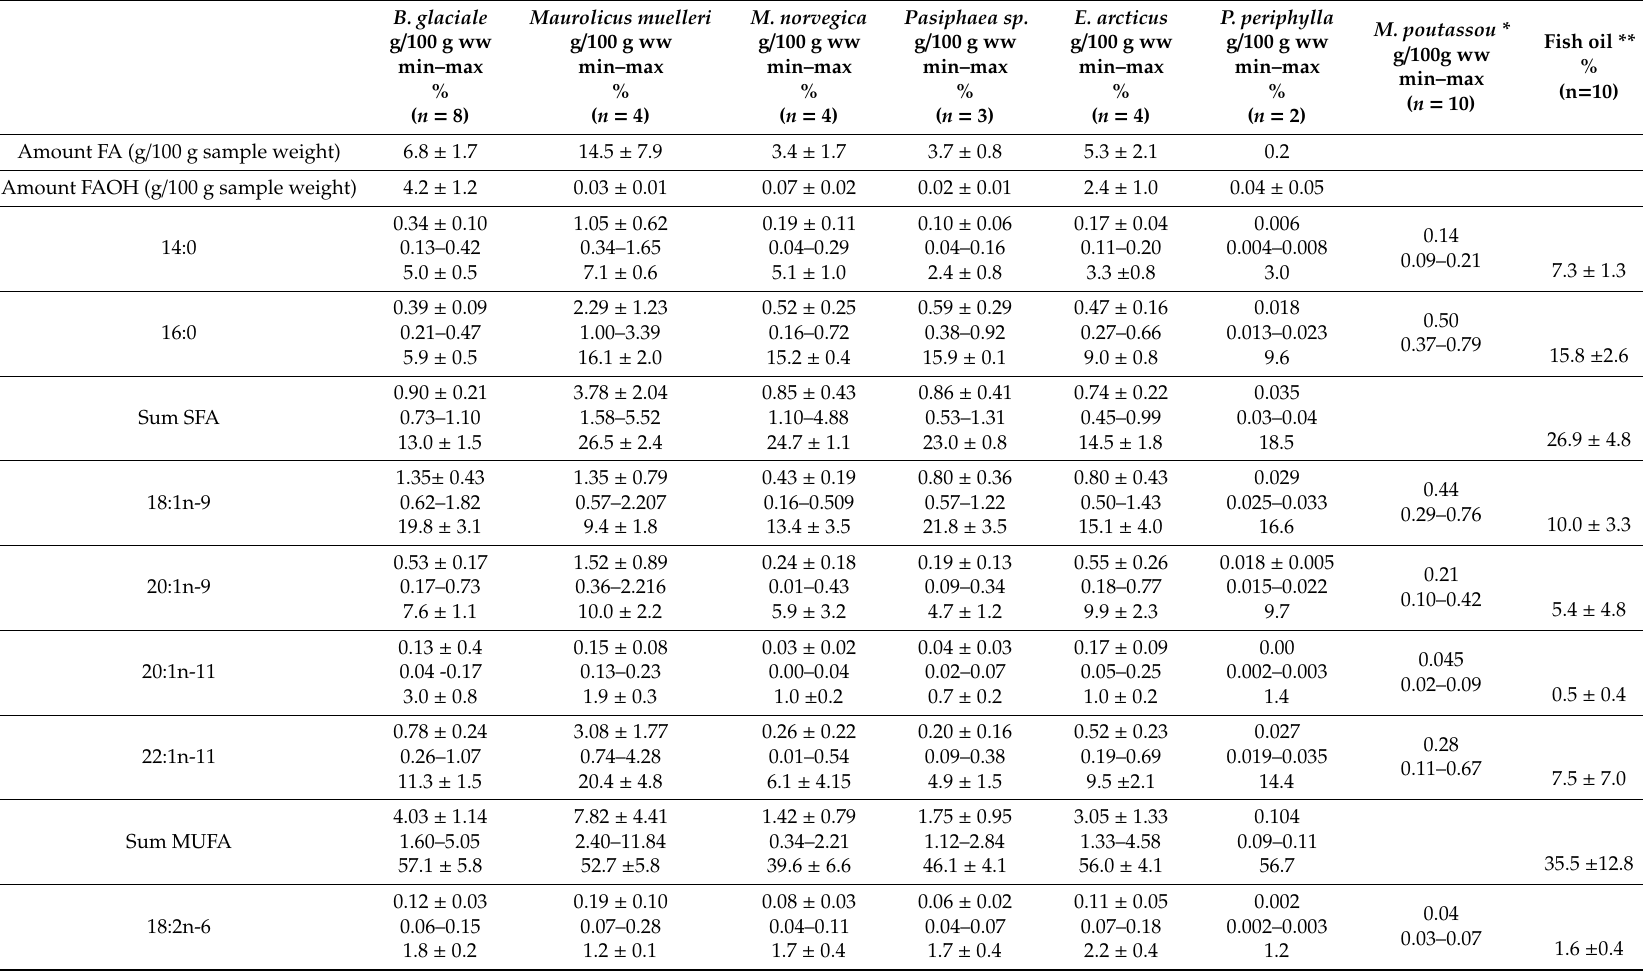
Table 4. Absolute and relative values of selected fatty acids in 6 mesopelagic species caught in three fjords in western Norway, and for comparison Blue whiting ( Micromesistius poutassou) and fish oil intended for aquaculture feed production (mean ±